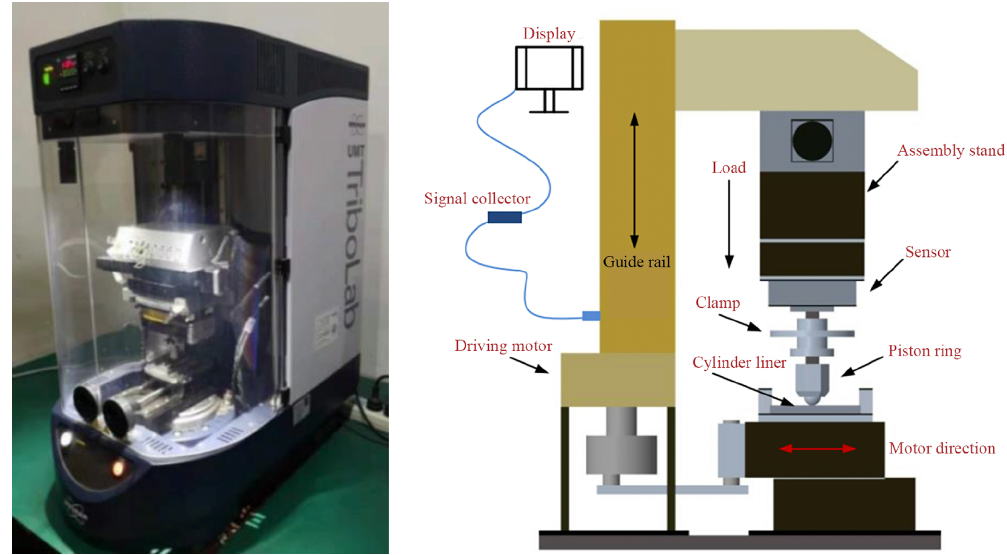
Figure 1. A photograph of the UMT TriboLab multifunction friction and wear tester as well as an outline of its structure.